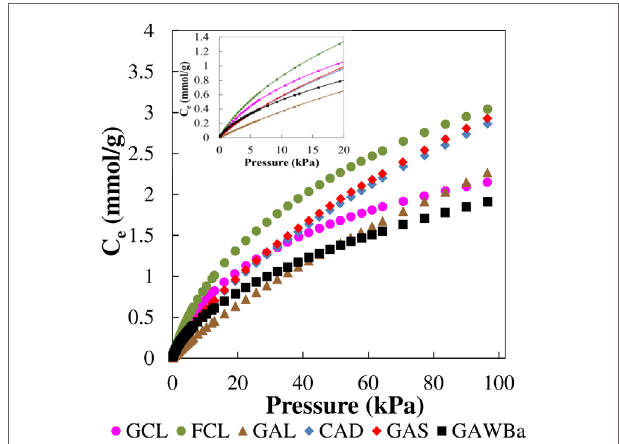
FigUre 5 | equilibrium adsorption isotherms of cO 2 at 25°c over all the samples